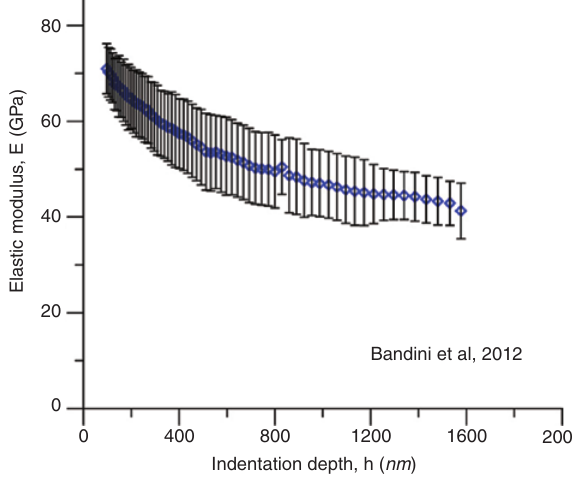
Figure 3: Indentation size effect of the elastic modulus in marble [5].